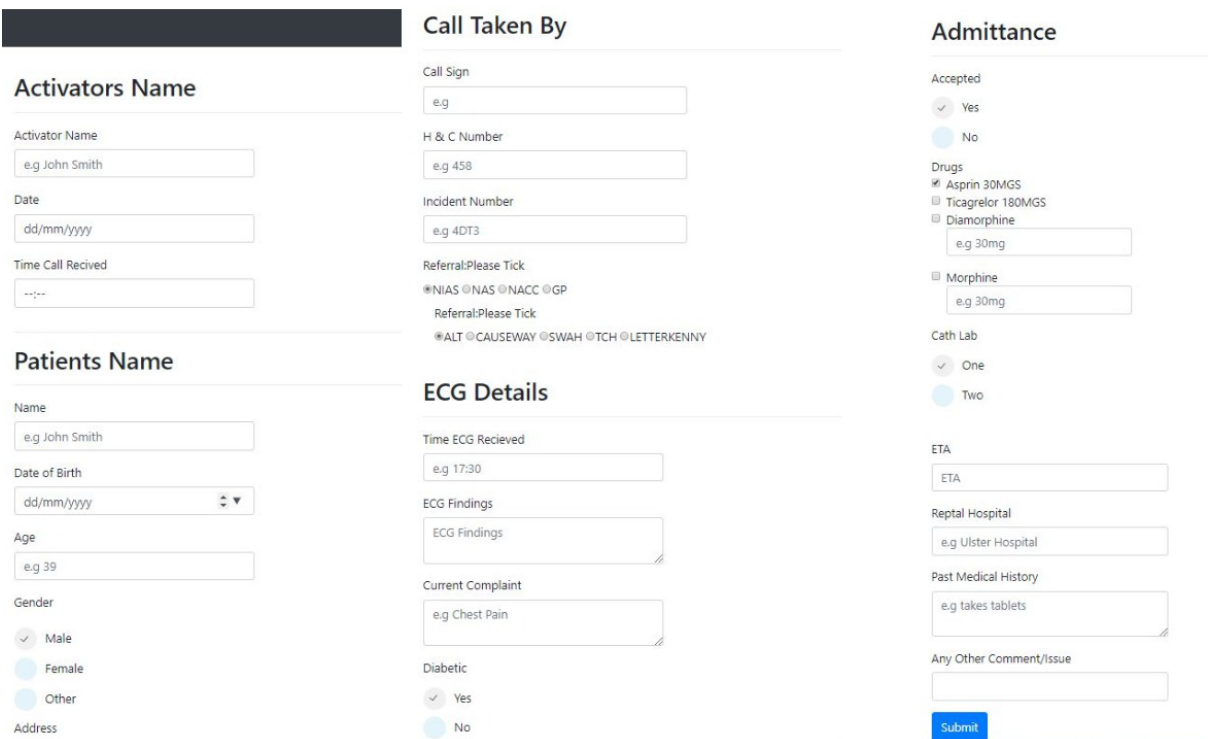
Figure 3. Screenshots of the screens from the multipage